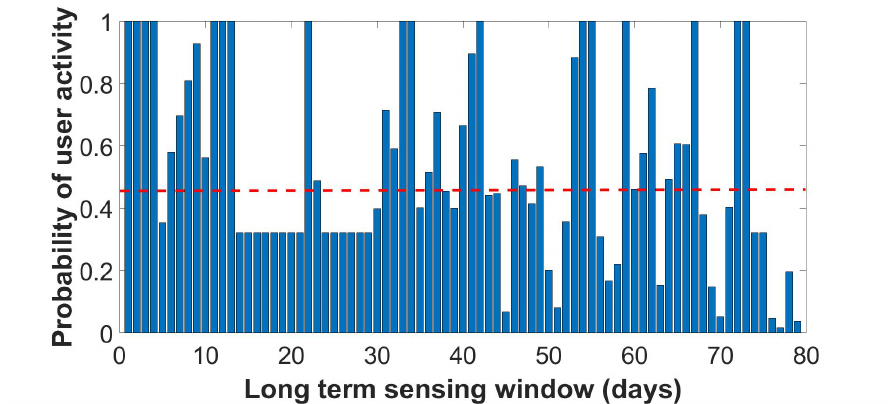
Figure 6. Probability of the selected moderate active user during sensing time window.